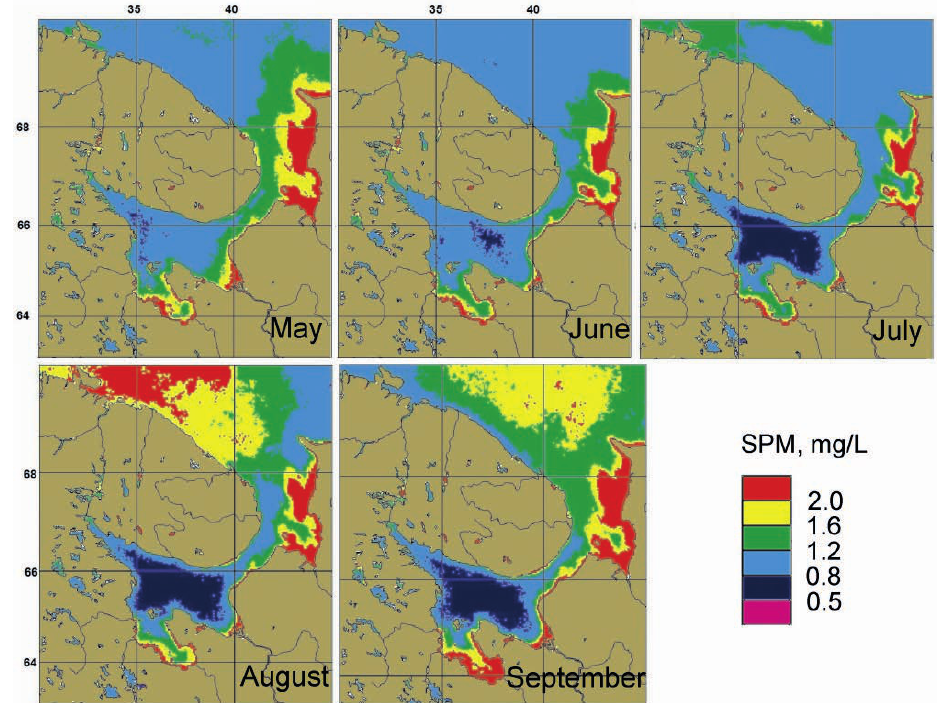
Fig. 3 Average monthly values of the SPM concentration based on the data from MODIS-Aqua satellite colour scanner. Images are composites over May–September in 2003–2010, provided by IO RAS Ocean Optic Laboratory, http://optics.ocean.ru (Burenkov et al. 2011). Table 1 Calculated average annual values of SPM and Chl a concentration and their mean square deviations in the White Sea according to MODIS-Aqua satellite observations. Years SPM Chl a (mg/L)